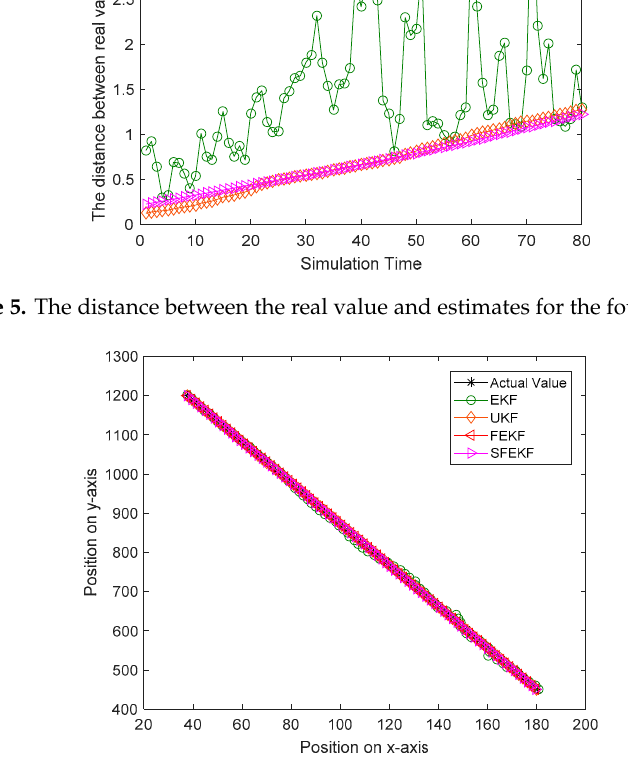
Figure 6. The real position and estimates for the four methods.